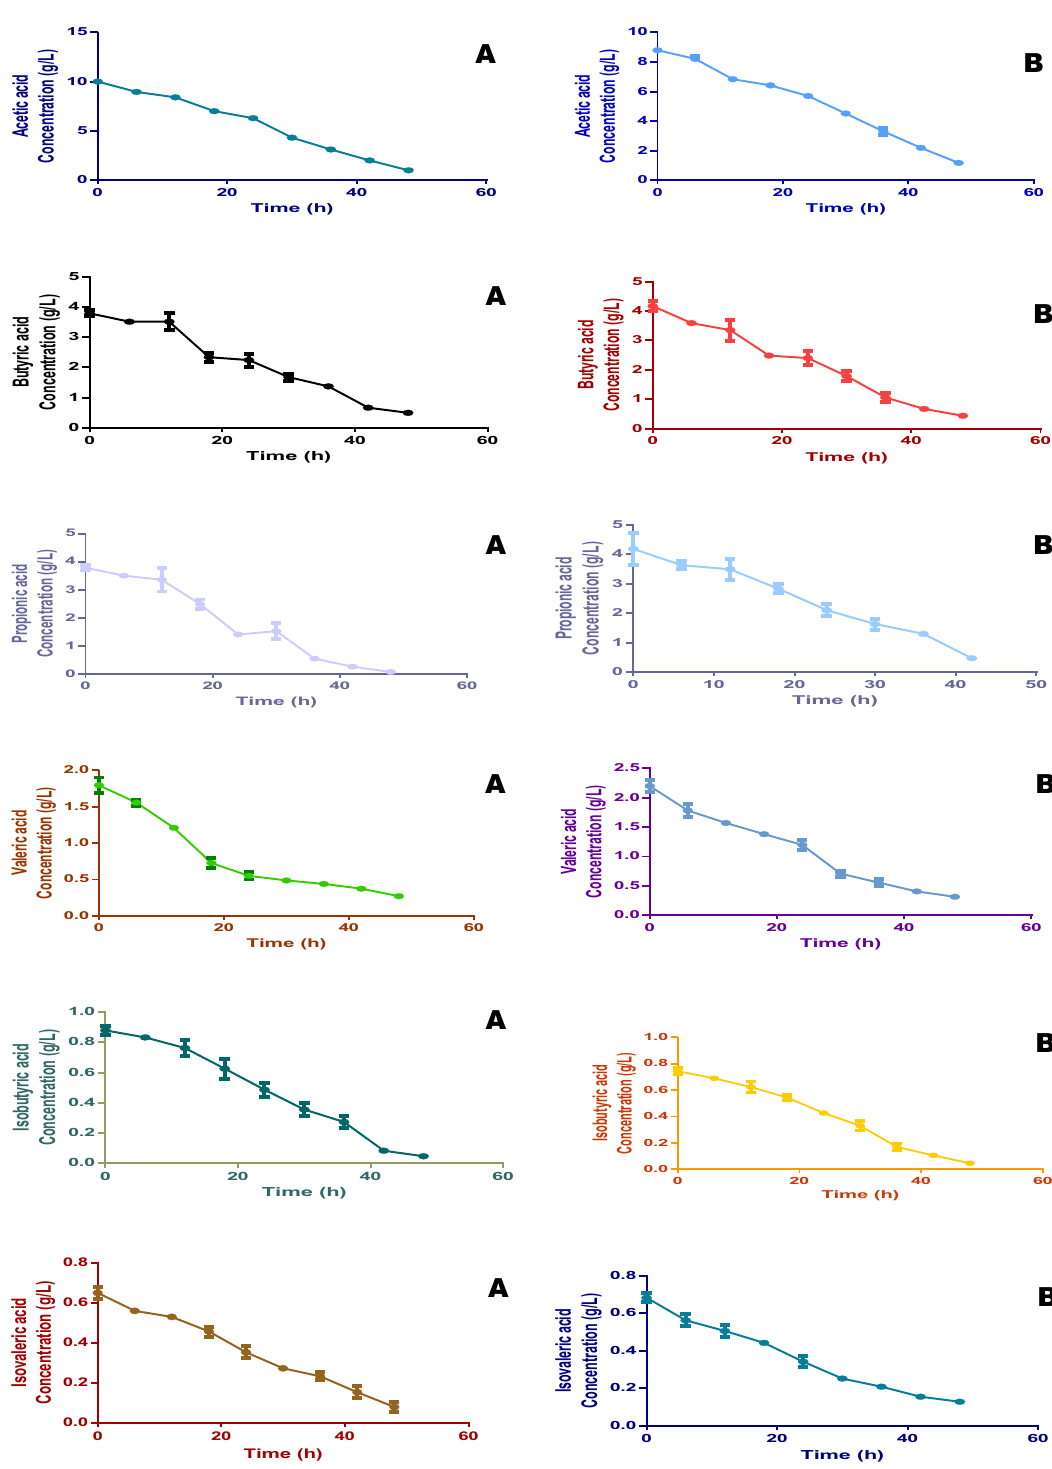
Figure 6. This figure shows the pattern of volatile fatty acids (VFAs) conversion for ( A ) food wastes and ( B ) spent animal beddings during the